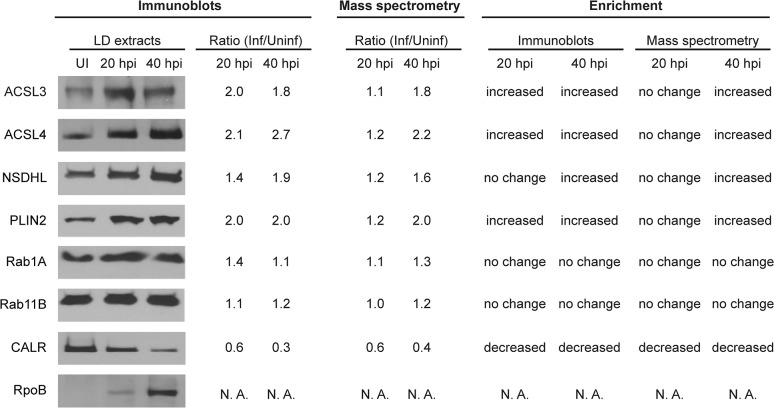
Immunoblot analysis of selected proteins identified in LD-extracts by proteomics.LD protein extracts were obtained from HeLa cells uninfected (UI) or C. trachomatis-infected for 20 h (20 hpi) and 40 h (40 hpi). Protein content was assessed by Bradford assay, equal amounts per lane were separated by SDS-PAGE and transferred to nitrocellulose membranes. The relative abundance of a subset of proteins associated to LD-extracts was assessed by immunoblot densitometry analysis (using ImageJ software) and compared with quantitative changes obtained from mass spectrometry (MS)-based quantification (expressed as the ratio, infected/uninfected). Proteins were considered “increased” or “decreased” when the Inf/Uninf ratio was > 1.5 or < 0.67 (this ratio representing a fold change greater or equal to -1.5), respectively, as shown in the “Enrichment” columns. Host proteins assessed were: ACSL3 (long-chain-fatty-acid-ligase 3); ACSL4 (long-chain-fatty-acid-ligase 4); NSDHL (sterol-4-alpha-carboxylate 3-decarboxylating); PLIN2 (perilpin-2); Rab1 (ras-related protein Rab-1a); Rab11 (ras-related protein Rab-11b); CALR (calreticulin). C. trachomatis RpoB (RNA polymerase subunit beta) was used as a marker of infection. A representative image is shown. N.A., “not applicable”.